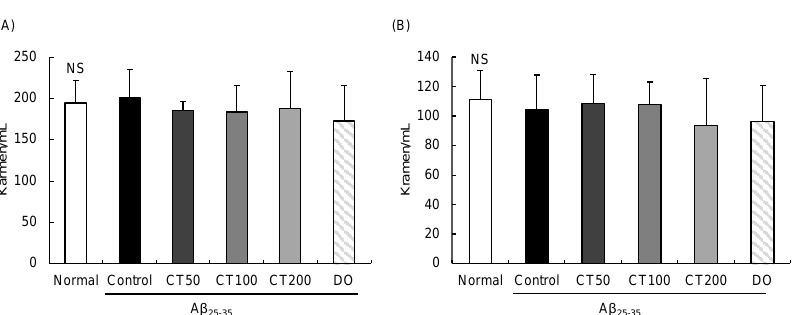
A β 25-35 + donepezil (5 mg/kg/day).